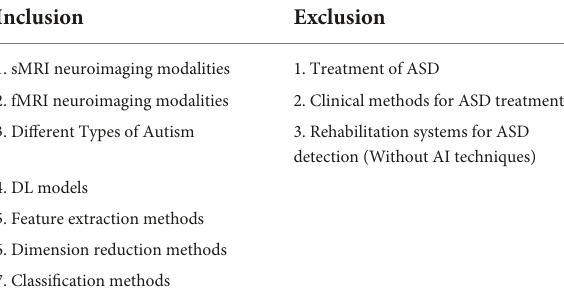
TABLE 1 The exclusion and inclusion criteria for diagnosis of ASD.